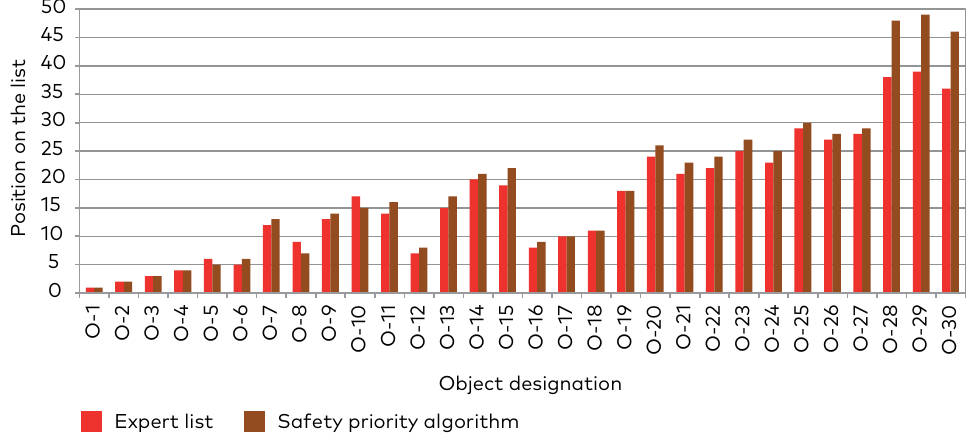
Figure 3. Comparison of a position in the expert list and the list created by the safety priority algorithm